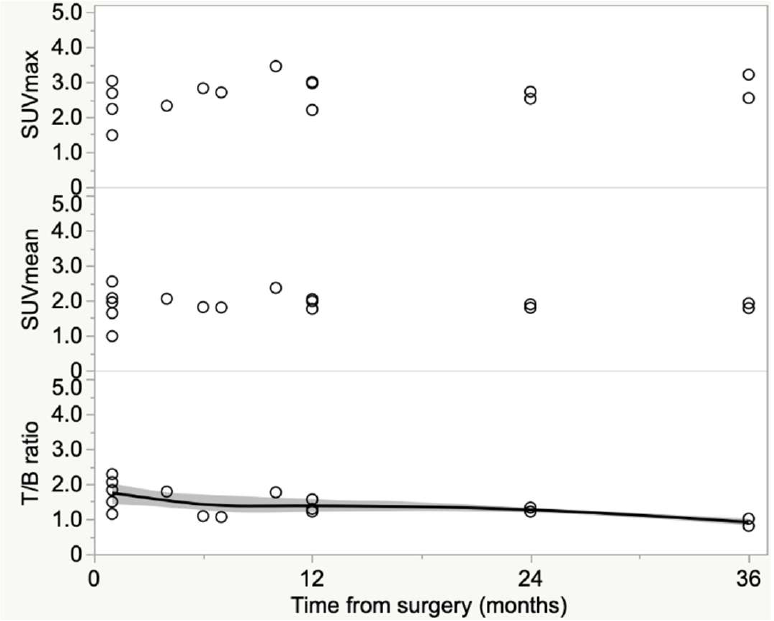
Figure 5. SUVmax, SUVmean and T/B ratios’ trend according to time from EVAR. Only T/B ratios showed a declining trend with increasing time ( ρ = − 0.61, 95% CI: ( − 0.85 to − 0.16), p =